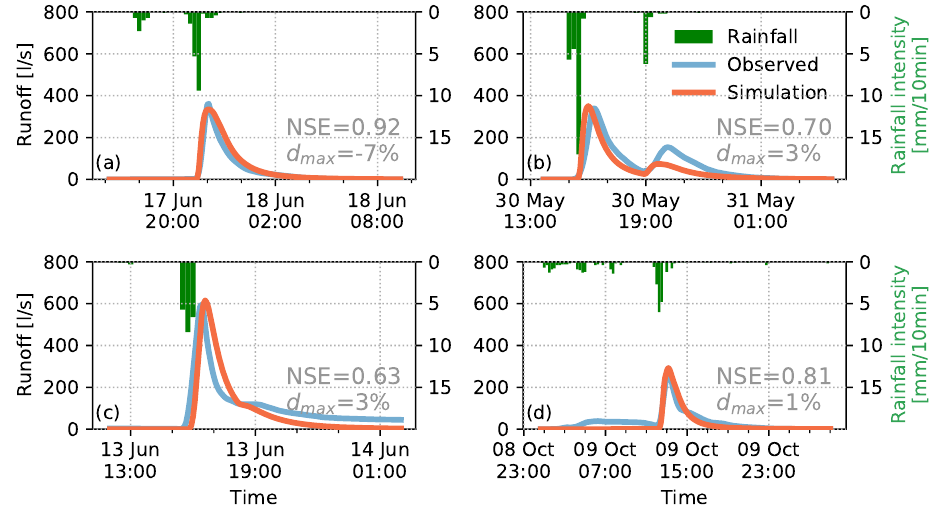
Figure 4. Results of calibration and validation for ( a ) event #1 (June 2011), ( b ) event #2 (May 2012), ( c ) event #3 (June 2012), and ( d ) event #4 (October 2012). Nash–Sutcliffe model efficiency E (NSE) and the difference between observed and predicted peak runoff d max (as percentage) are indicated for each